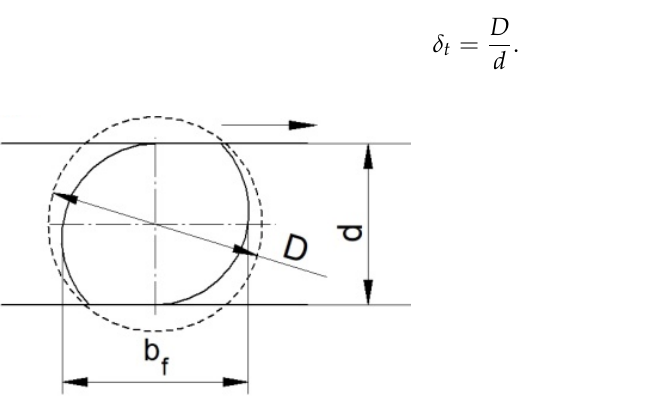
Figure 10. Schematic of the CWR process with flat tools with marked geometrical parameters.